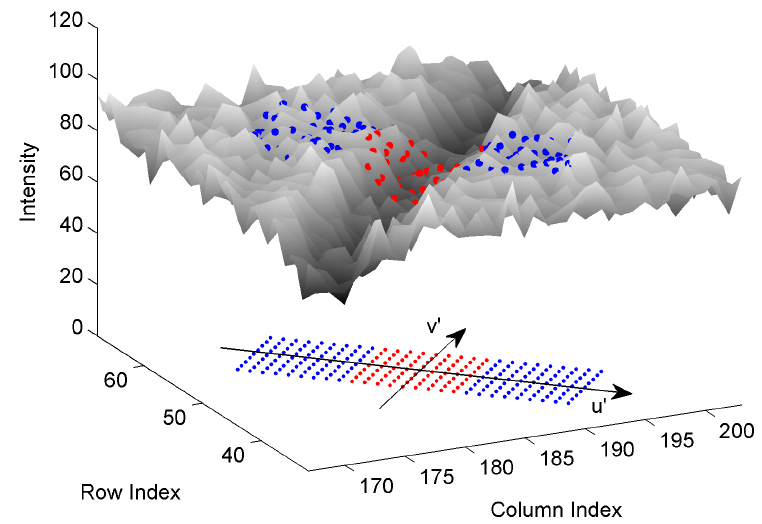
Figure 4. Representation of the discrete domain defined by the span of the variables ( u (cid:48) , v (cid:48) ) within the admissible boundaries. Each coordinate is projected on the surface made by the gray values of the input image. The resulting samples constitutes the three vectors Y elements ( i = 1 , 2 , 3 . ).